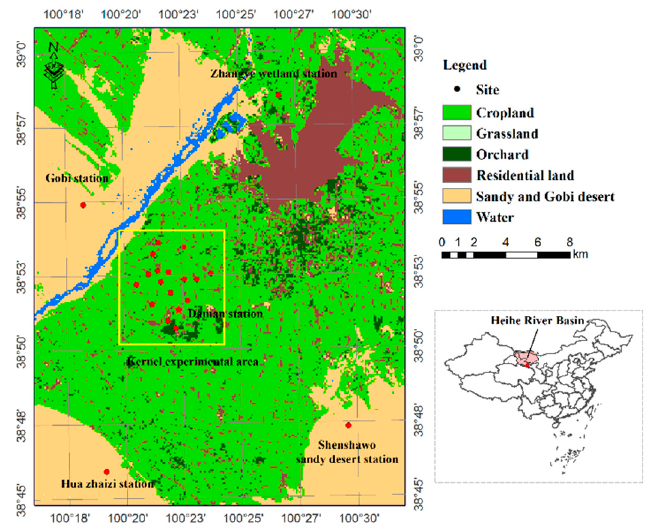
Figure 1. The distribution of flux towers and the land use classifications in MUSOEXE over the Zhangye oasis. The yellow rectangular in the left shows the kernel experimental area in MUSOEXE, and the subset figure in the lower right shows the location of MUSOEXE (marked in red triangle) in the Heihe River Basin (marked by pink polygon) and in China.